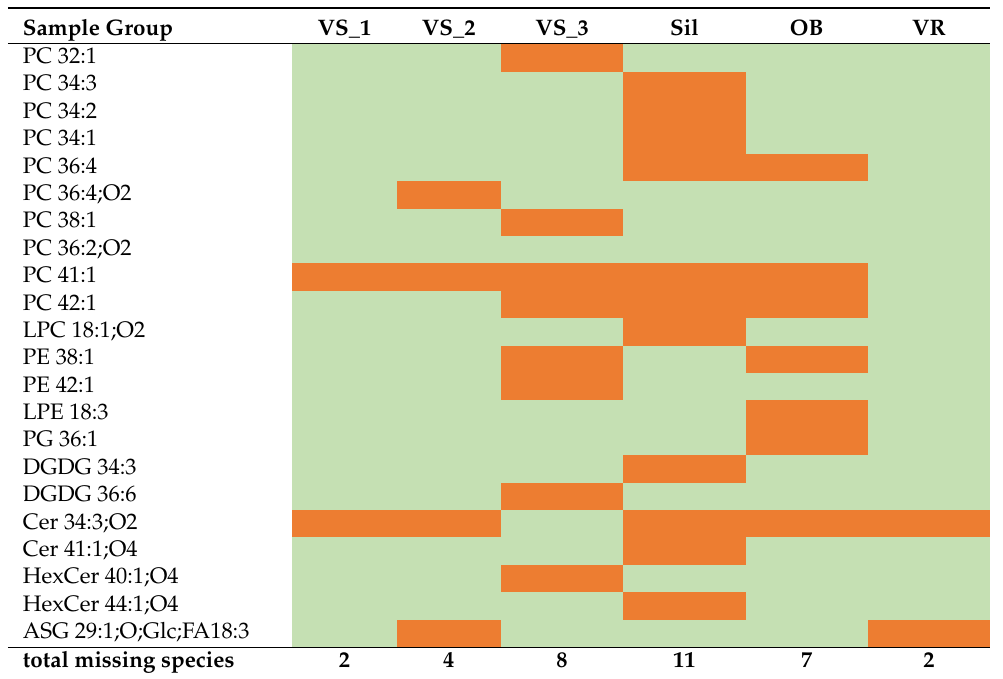
Table 1. Missing species of polar lipids identified in the olive seeds cv. Galega vulgar from different sub-regions of Nelas,